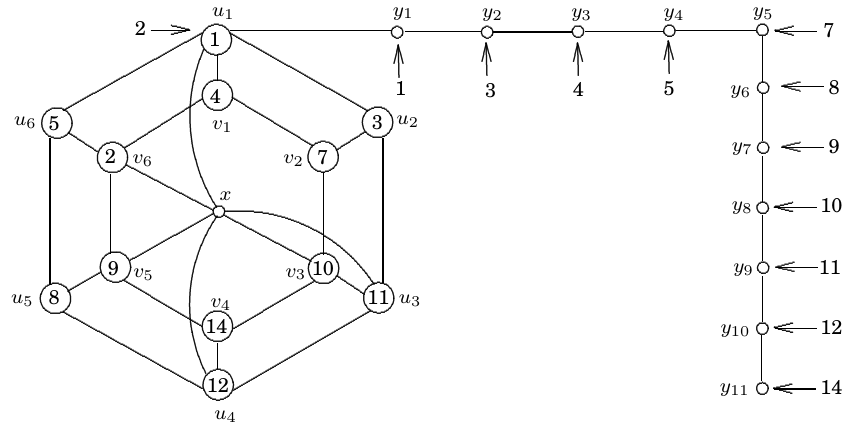
Figure 15: The graph G